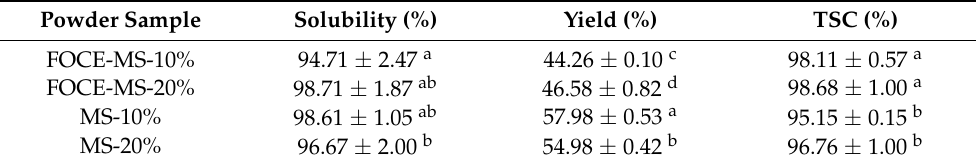
Table 4. Solubility, yield, and total solids content (TSC) of the spray-dried emulsion